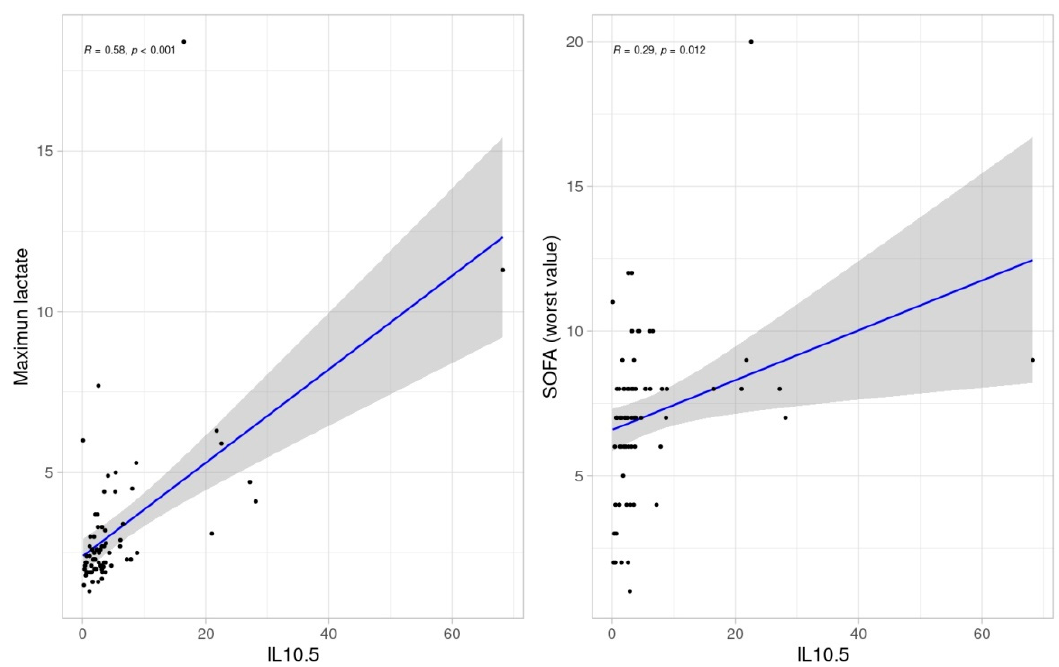
Figure 4. Scatter dots of correlations between fT4 and cytokines at day 5. At day 5, fT4, was inversely correlated with IL-10 ( p = 0.035). In the same direction, IL-10 was associated with maximum lactate ( p < 0.001) and SOFA score values ( p = 0.012) (Figure 5).